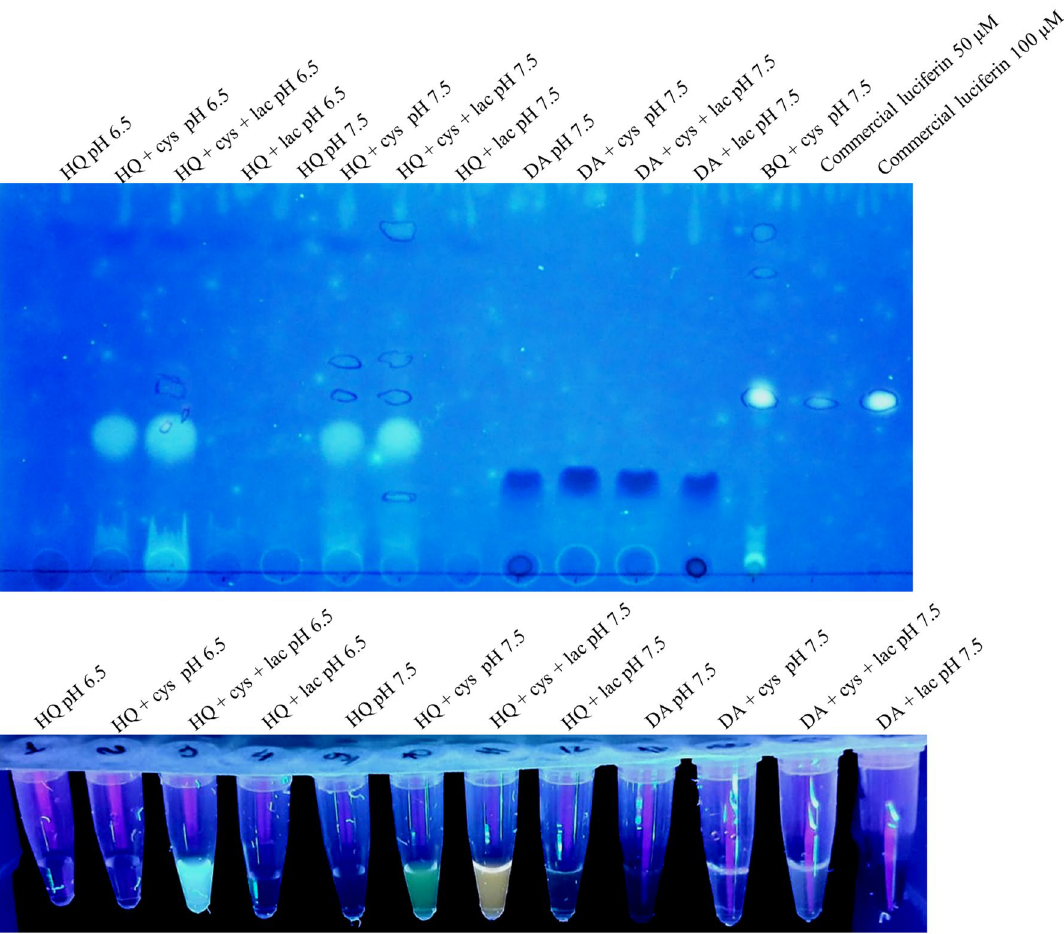
Figure 3. Thin Layer Chromatography of reactions of luciferin synthesis (upper panel) and fluorescence under UV light irradiation of these samples (lower